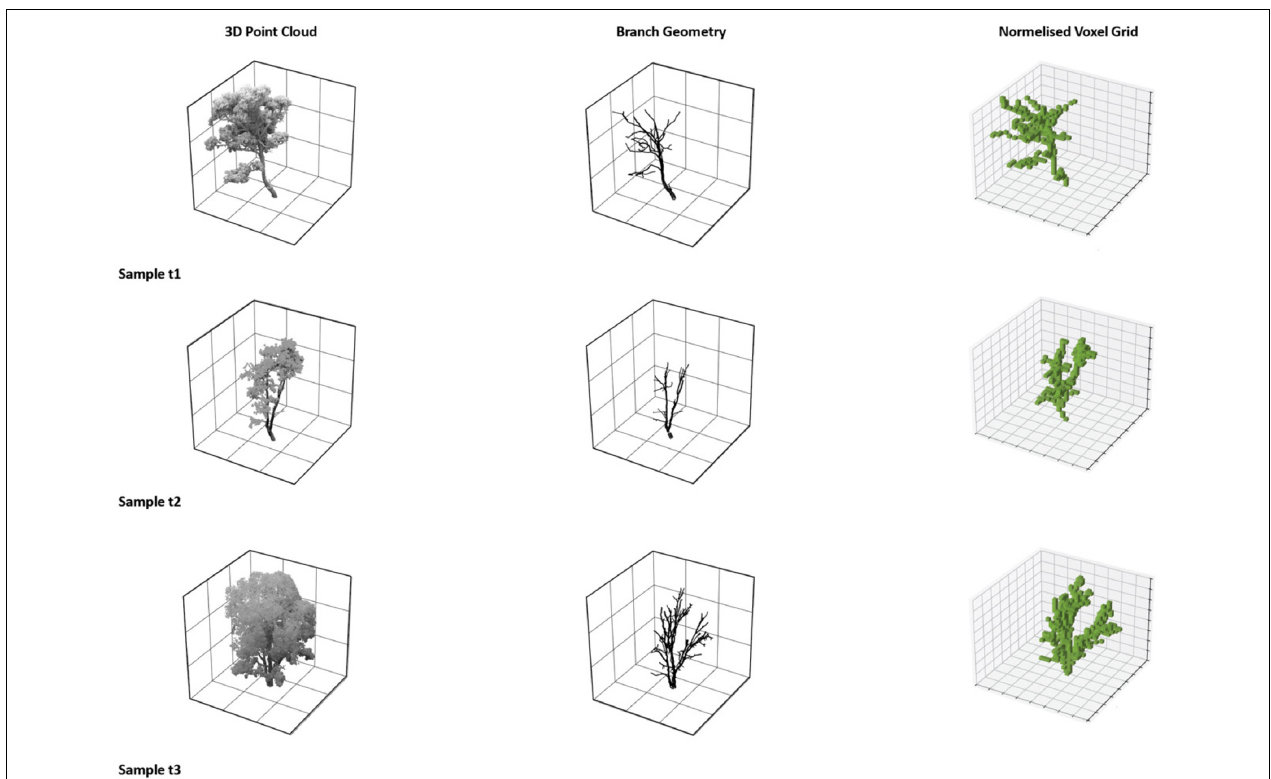
FIGURE 3 | Conversion of the 3D scans of existing trees into 32 × 32 × 32 normalised voxel representations to create the natural habitat-structure